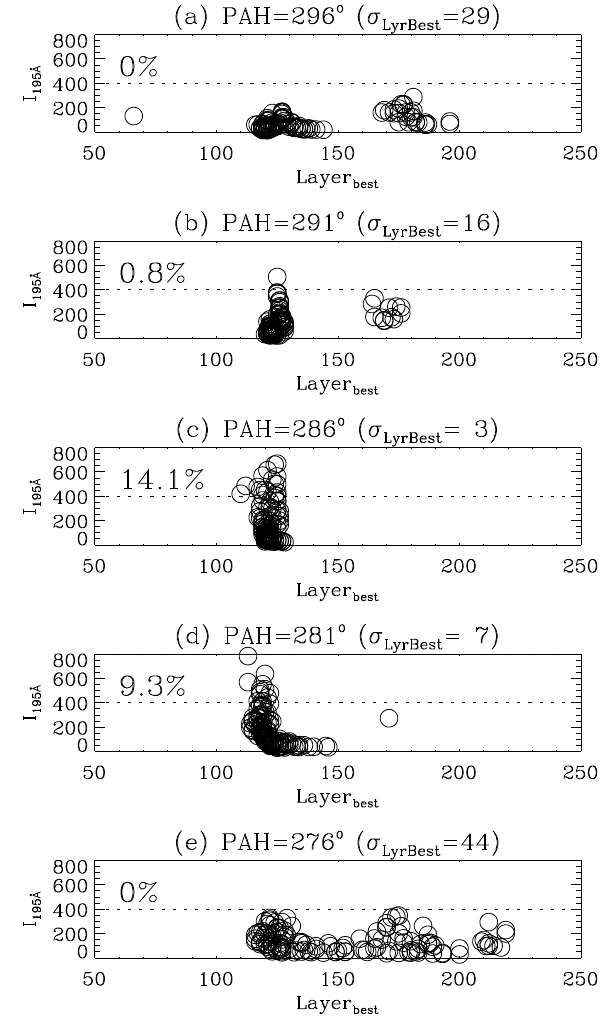
Fig. 5. Relation between layer best (IR emission sources locations by Liu and Lin’s method; with open circles) and the corresponding EUV brightness at limb. It can be concluded that, for one coronal region, the larger the percentage of bright EUV points ( I > 0 . 5 I max ) it has, the more compact the distribution of the IR emission sources appears (parameterized by σ LyrBest ).